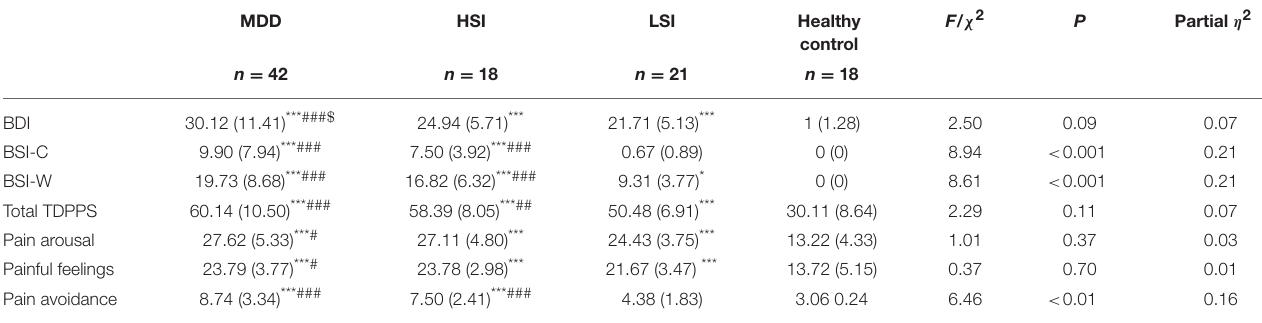
TABLE 5 | Differences in questionnaire scores among the MDD, HSI, LSI, and healthy control